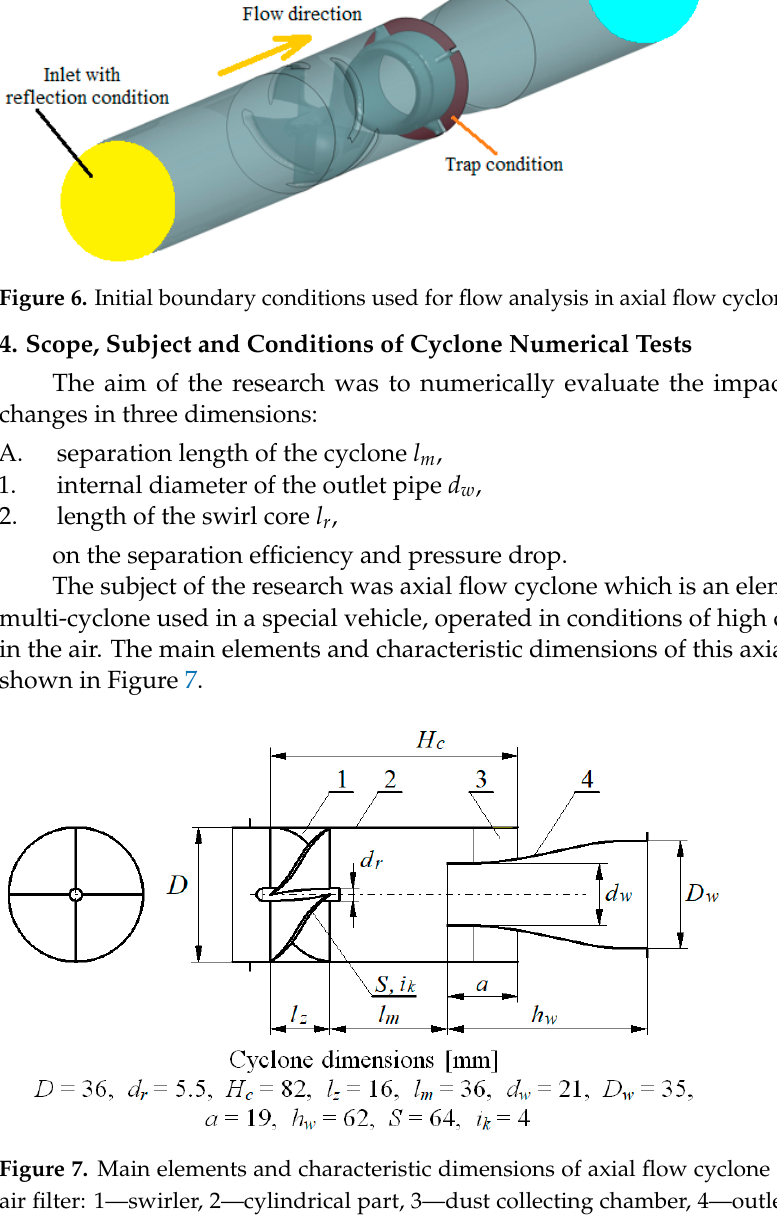
Figure 5. Flow domain in axial flow cyclone.